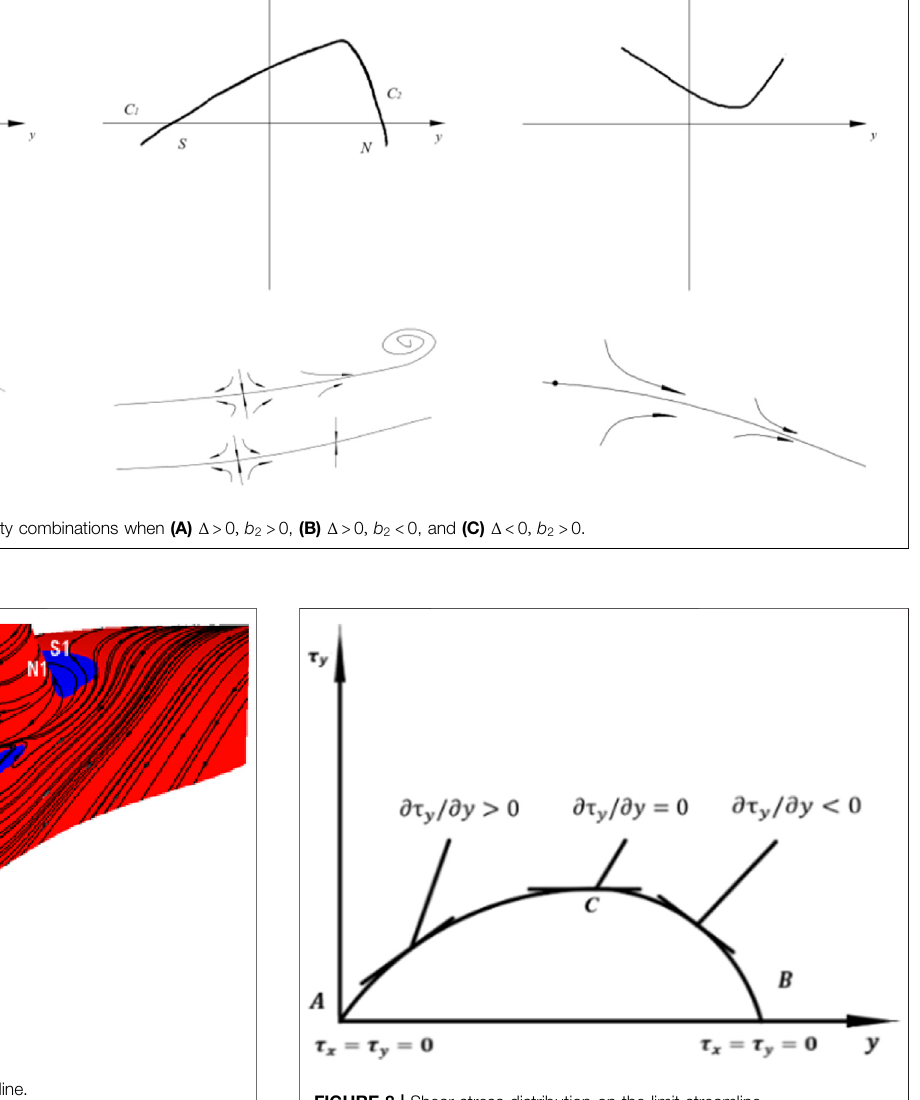
FIGURE 8 | Shear stress distribution on the limit